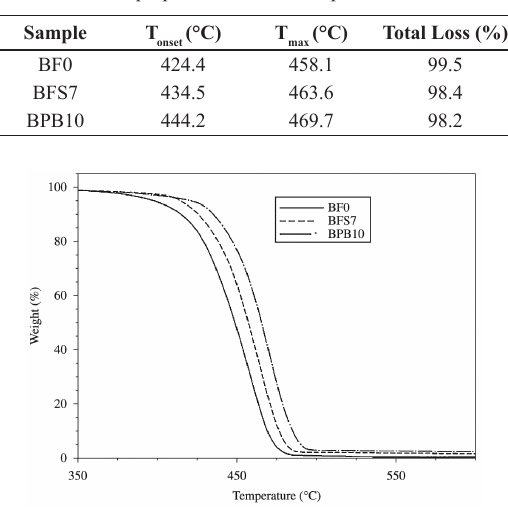
Figure 8. Profiles of thermogravimetric analysis of the crosslinked samples.